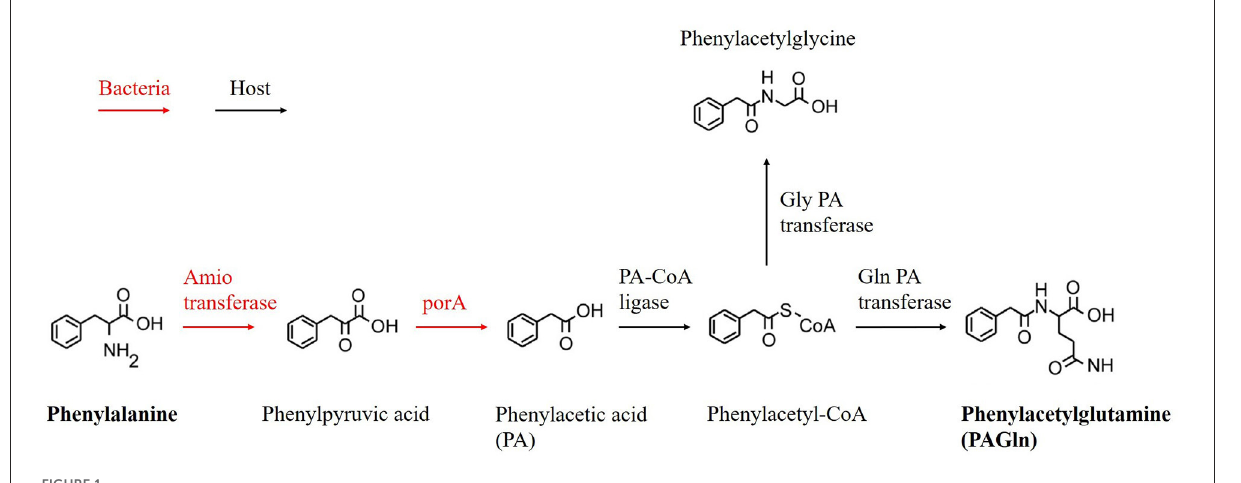
FIGURE1 Proposed metabolic pathway for production of